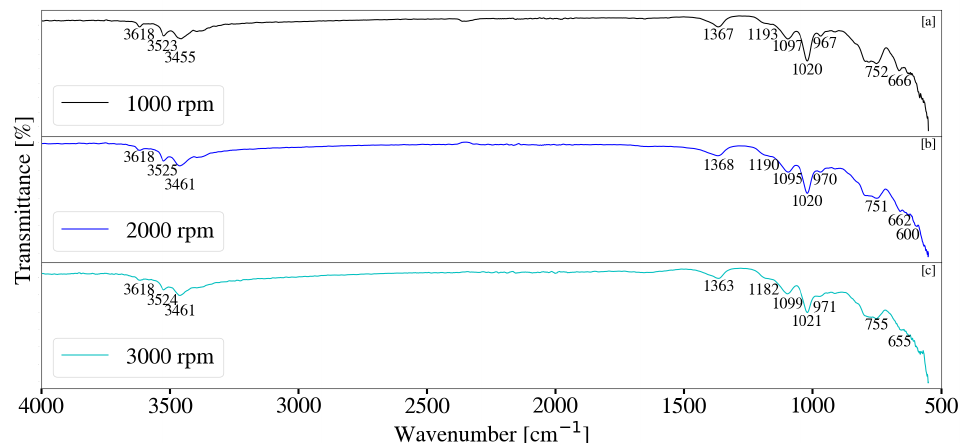
Figure 14. ( a ) FT-IR analysis for Mg-Al LDH sample synthesised at a rotational speed of 1000 rpm (S1). ( b ) FT-IR analysis for Mg-Al LDH sample synthesised at a rotational speed of 2000 rpm (S2). ( c ) FT-IR analysis for Mg-Al LDH sample synthesised at a rotational speed of 3000 rpm (S3). Milling parameters were set at a retention time of 1 h, jacket water inlet temperature of 30 °C, media size of 2 mm and a solids loading of 10%.